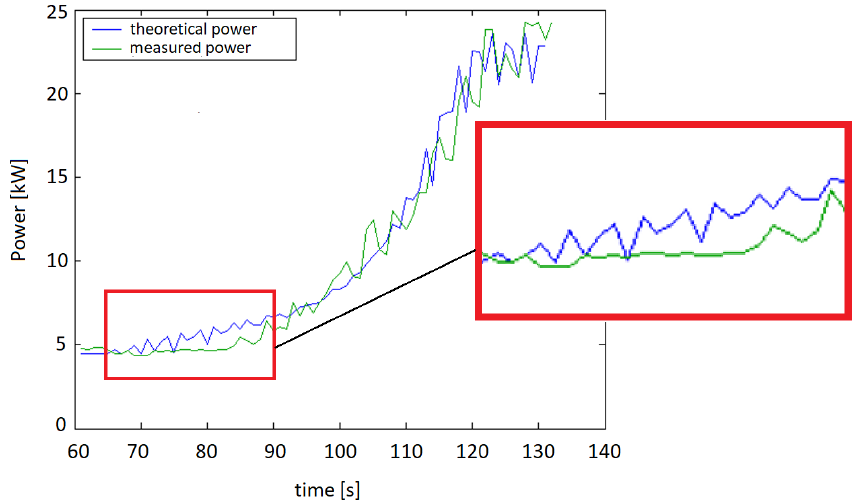
Figure 6. Comparison between theoretical and measured power.